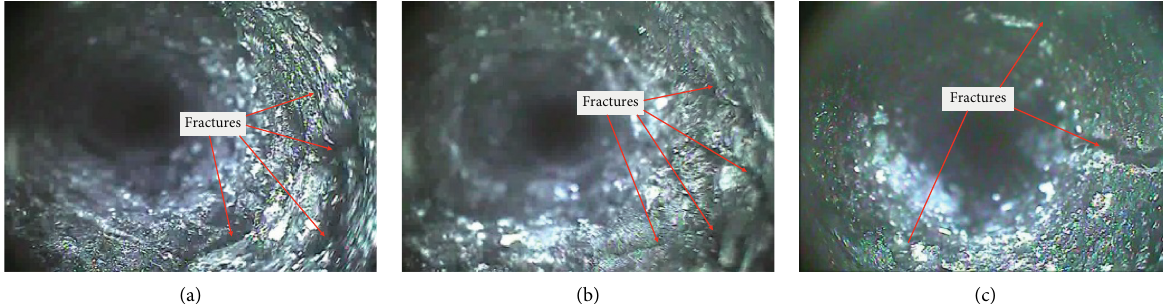
Figure 7: Photographs of a coal pillar with different borehole depths obtained by a rock layer detection recorder. (a) Borehole depth of 2 (m).(b) Borehole depth of 4m. (c) Borehole depth of